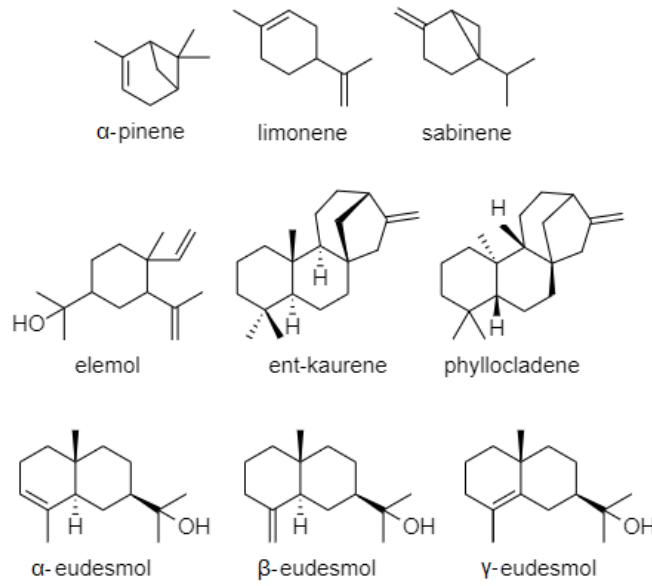
Figure 1. Some of the major components of Cryptomeria japonica leaf essential oil.